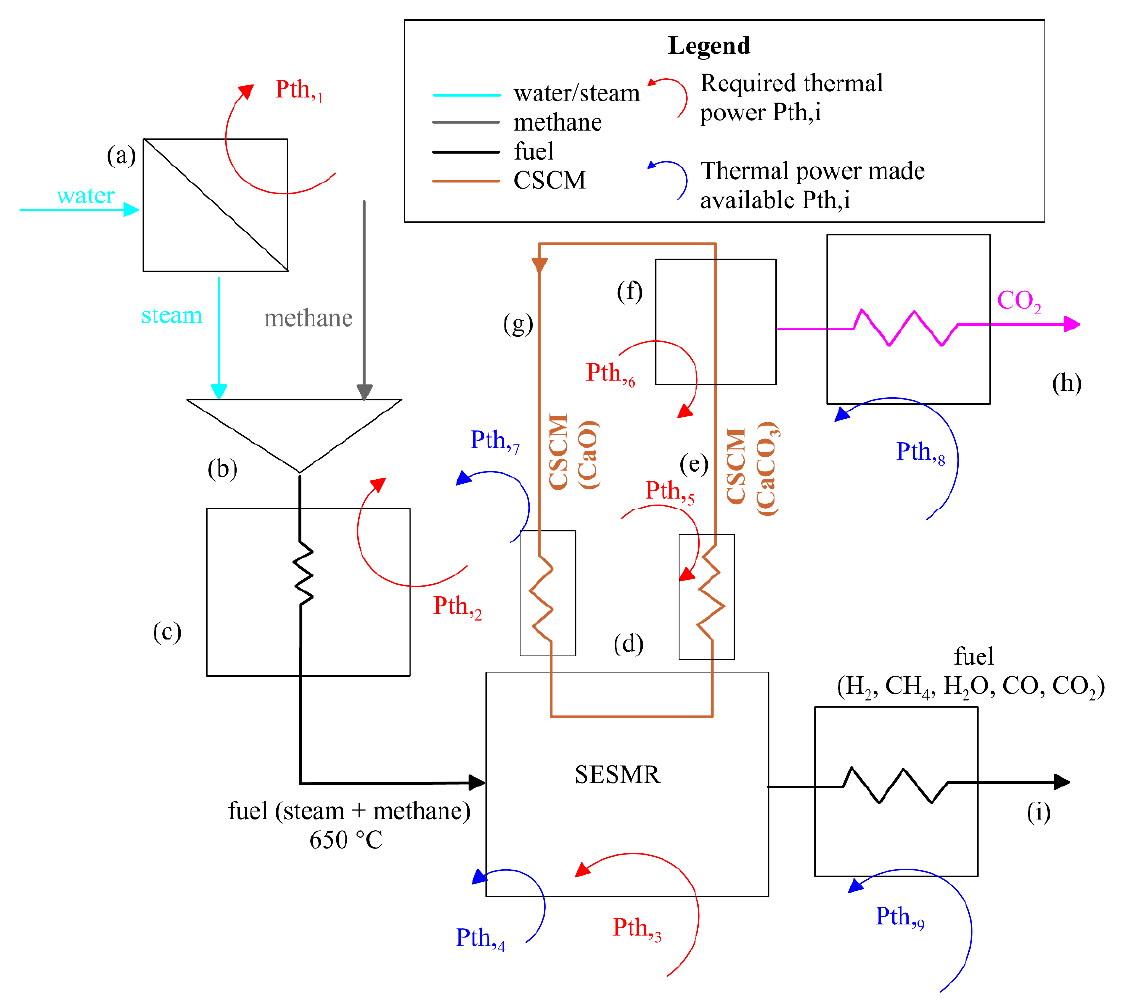
Figure 1. Scheme of the energetic model of SESMR.